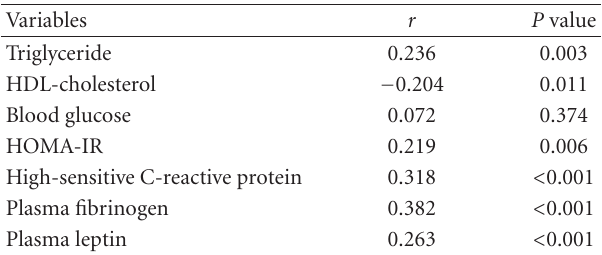
Table 4: Correlations between plasma viscosity and biochemical